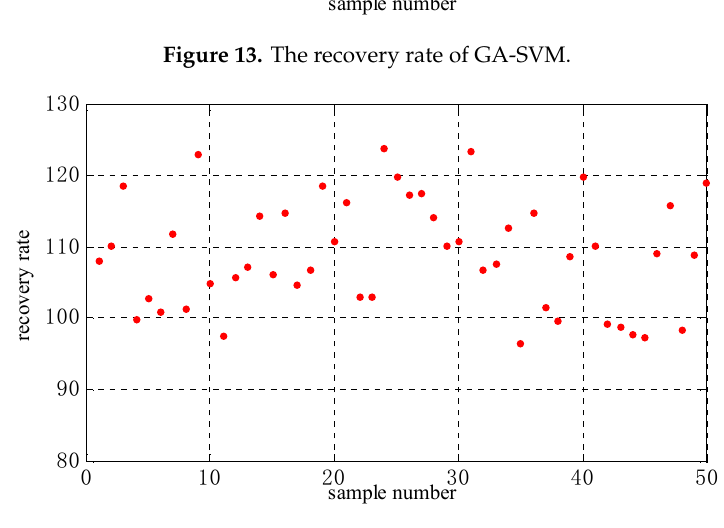
Figure 14. The recovery rate of PSO-SVM. Table 4. The recovery rates and the mean squared errors of four